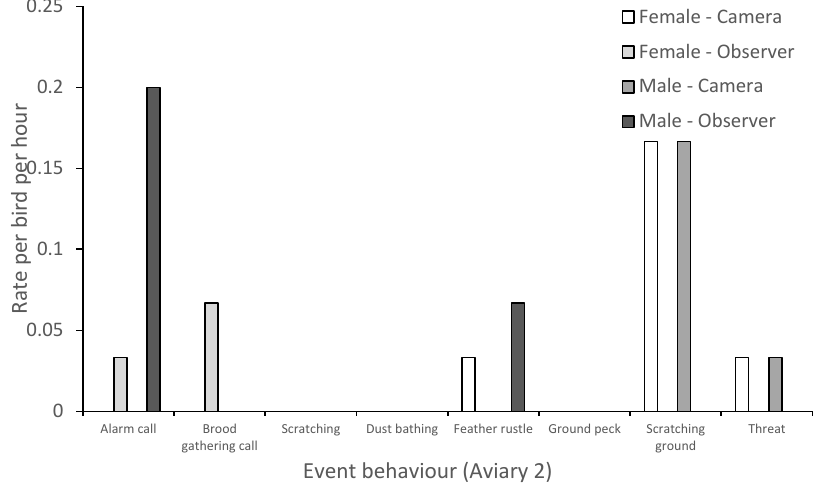
Figure 5. Rate of event behavior of pheasant pair housed in aviary 2, as compared between observer and camera conditions. Table 3. Output of Poisson regressions for Edwards’ pheasant state behavior. * indicates a signifi- cant value.